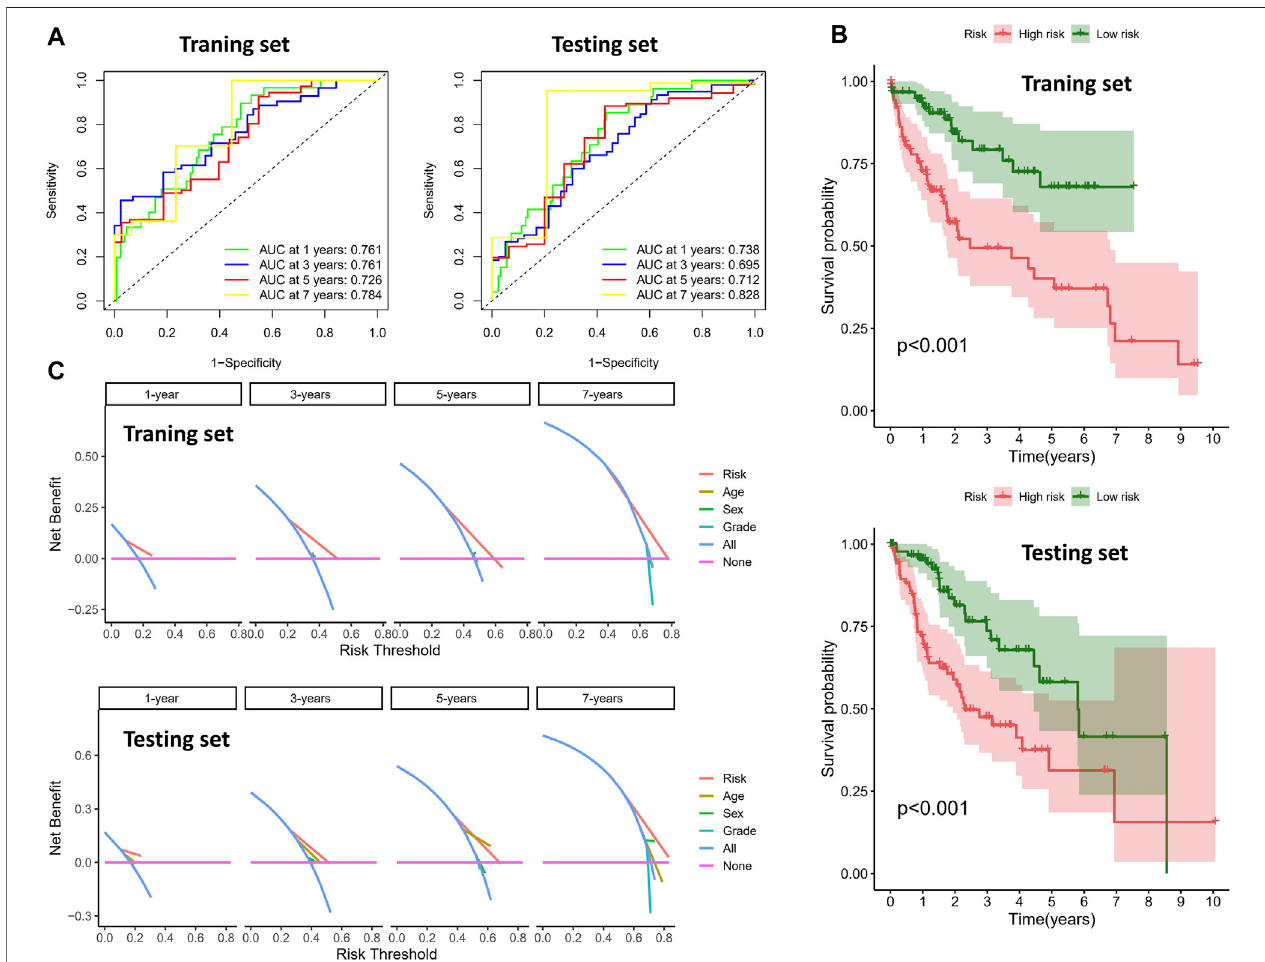
FIGURE2| Clinicalbene fi tsusingnovelsignature. (A) ROCanalysisindifferentsets(theleft fi gureisthetrainingsetandtheright fi gureisthetestingset). (B) Survival analysisofdifferent riskgroups(the top fi gure isthetraining set and the bottom fi gure isthetesting set). (C) DCA analysisin differentsets (the top fi gure isthetraining set and the bottom fi gure is the testing